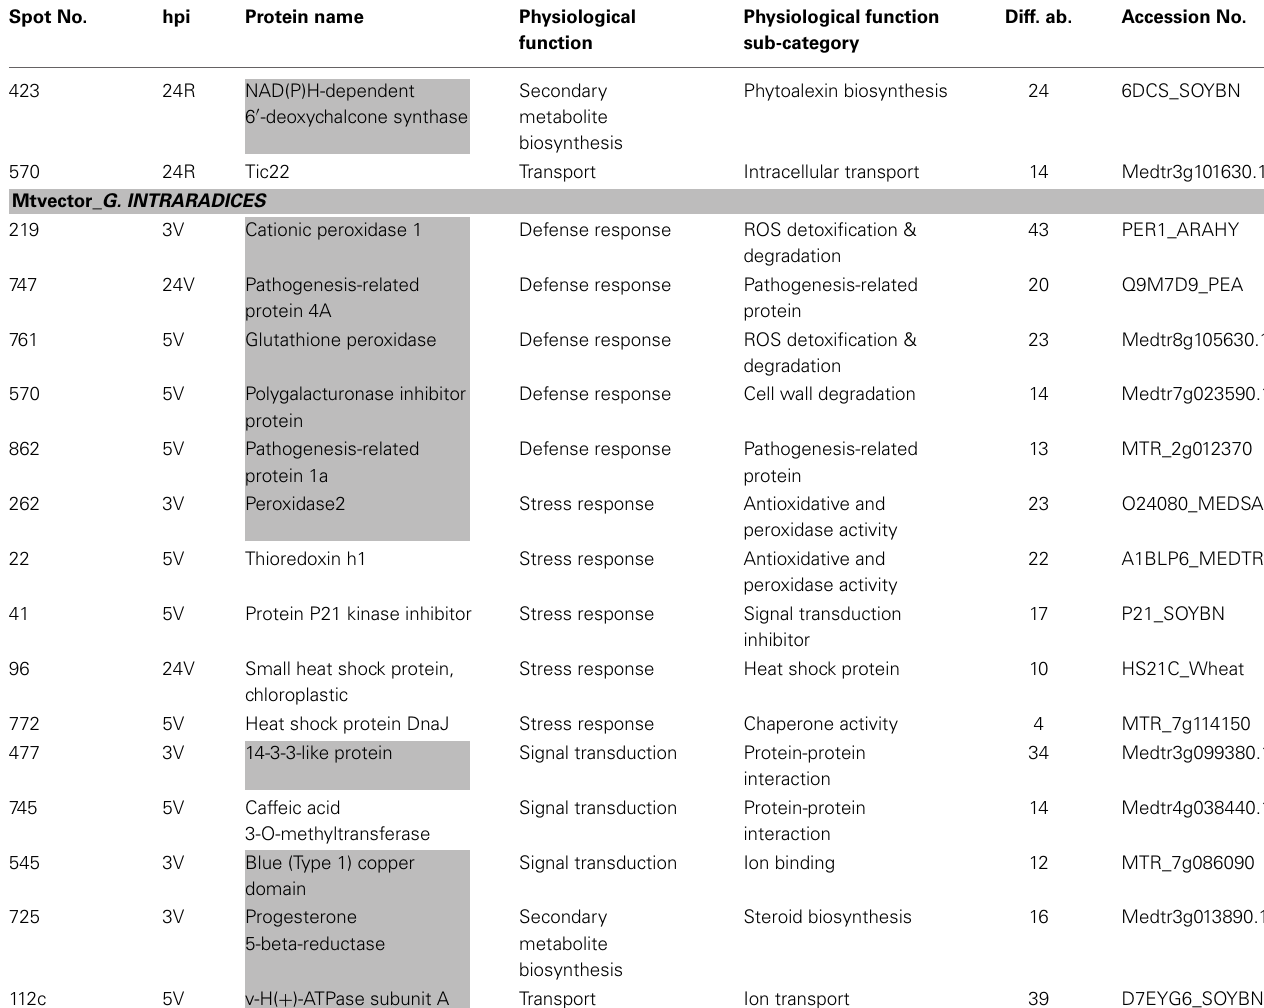
List of proteins identified with highest induction in abundance for the selected physiological function categories after infection with S. meliloti, A. euteiches and G. intraradices for the time points 1h, 3h, 5h, and 24h. Proteins names that are underlayed with gray color are discussed in the manuscript.